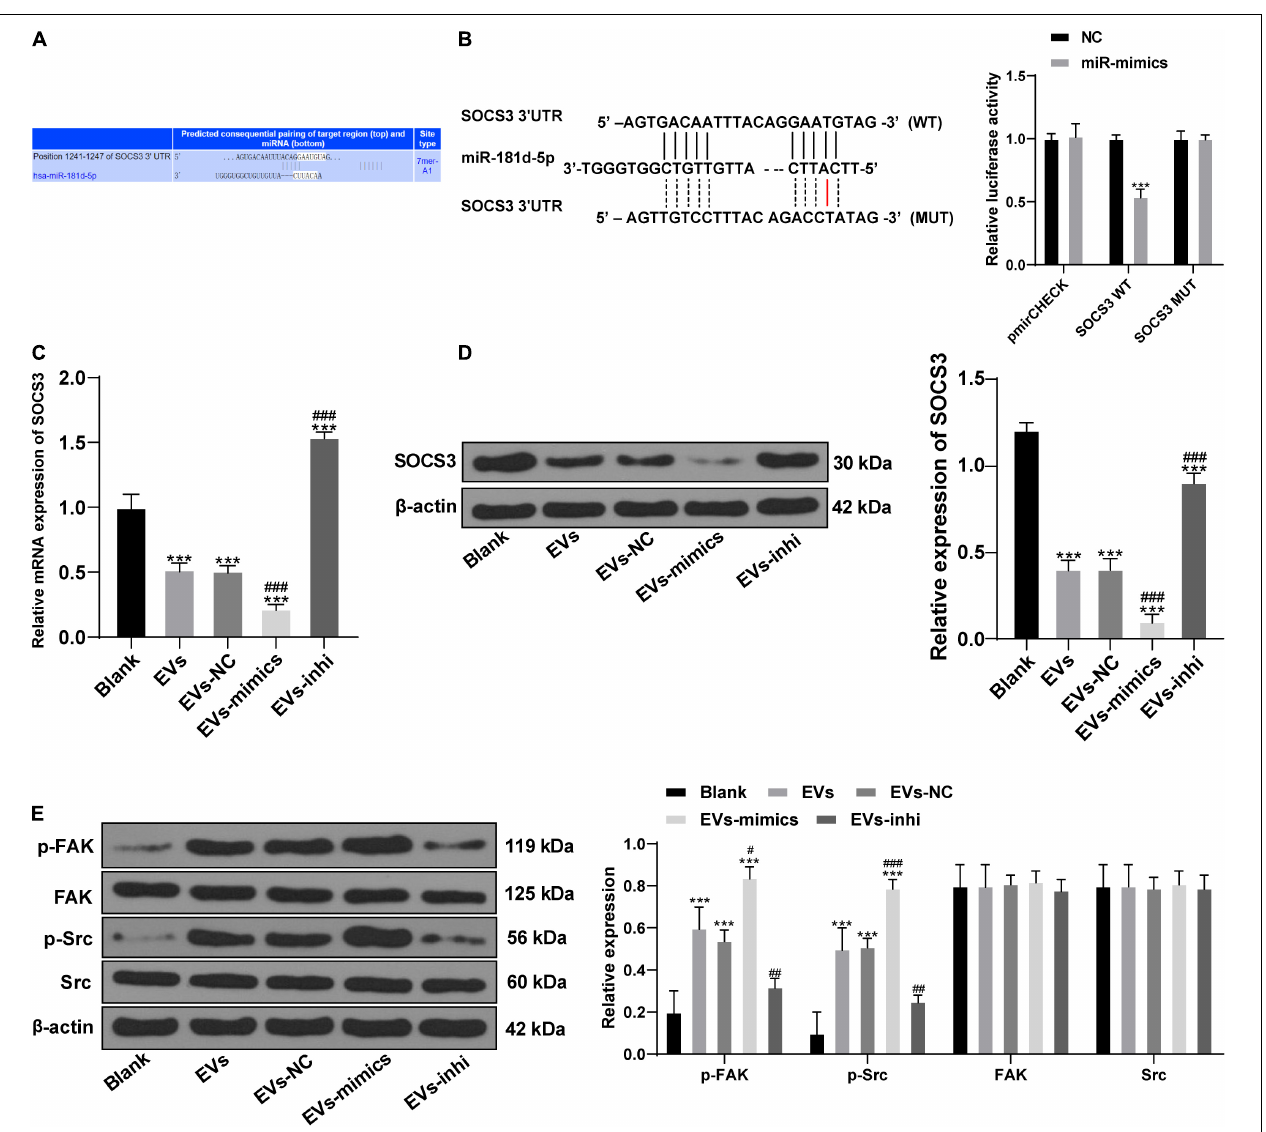
FIGURE 6 | miR-181d-5p carried by hepatoma cell-derived EVs targeted SOCS3 to activate the FAK/Src pathway. (A) the online search and analysis of the database (http://www.targetscan.org) found that SOCS3 and miR-181d-5p had a targeted binding site. (B) The targeting relationship between miR-181d-5p and SOCS3 was further verified by dual luciferase reporter gene assay; compared to the NC, *** p < 0.001. (C) mRNA expression of SOCS3 in BMSCs was detected by RT-qPCR. (D,E) Levels of SOCS3 and the FAK/Src pathway-related proteins in EVs-treated BMSCs were detected by Western blot analysis. Compared with the blank group, *** p < 0.001; compared with the EVs group, # p < 0.05, ## p < 0.01, ### p < 0.001. Data in panel (B) were analyzed by t test, and data in panels (C–E) were analyzed by one-way ANOVA, followed by Tukey’s multiple comparison test. Replicates =